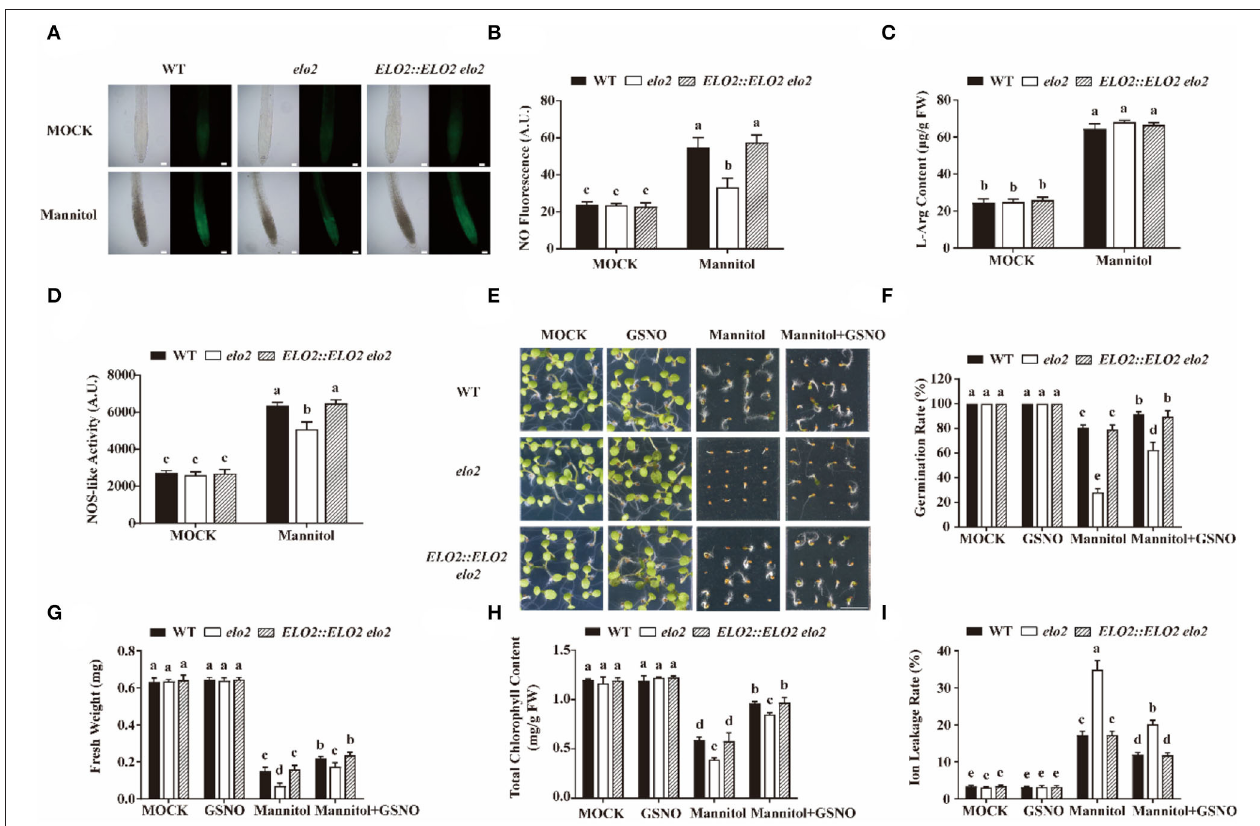
FIGURE 2 | ELO2 affects NOS-like activity to modulate osmotic stress-induced NO accumulation. (A,B) Representative images (A) and fluorescence (B) of DAF-FM DA staining in 5-day-old WT, elo2 , and ELO2::ELO2 elo2 plants under the treatment of 250mM mannitol for 12h. Scale bars = 200 µ m. (C,D) L-Arg content (C) and NOS-like activity (D) of 5-day-old WT, elo2 , and ELO2::ELO2 elo2 seedlings under the treatment of 250mM mannitol for 12h. FW: fresh weight. (E–G) Phenotypes (E) , germination rate (F) , and fresh weight (G) of wild-type, elo2 , and ELO2::ELO2 elo2 plants under the treatment of 50 µ M GSNO, 250mM mannitol, and 250mM mannitol plus 50 µ M GSNO for 5 days Scale bars = 0.5cm. (H,I) Total chlorophyll content (H) and ion leakage rate (I) of 5-day-old WT, elo2 , and ELO2::ELO2 elo2 seedlings treated with or without 50 µ M GSNO, 250mM mannitol, and 250mM mannitol plus 50 µ M GSNO for 12h. FW: fresh weight. A.U. indicates the pixel intensity arbitrary units of DAF-FM DA fluorescence. Data shown are means ± SD of three independent biological replicates. Different letters indicate significantly different values ( P < 0.05 by Tukey’s test).